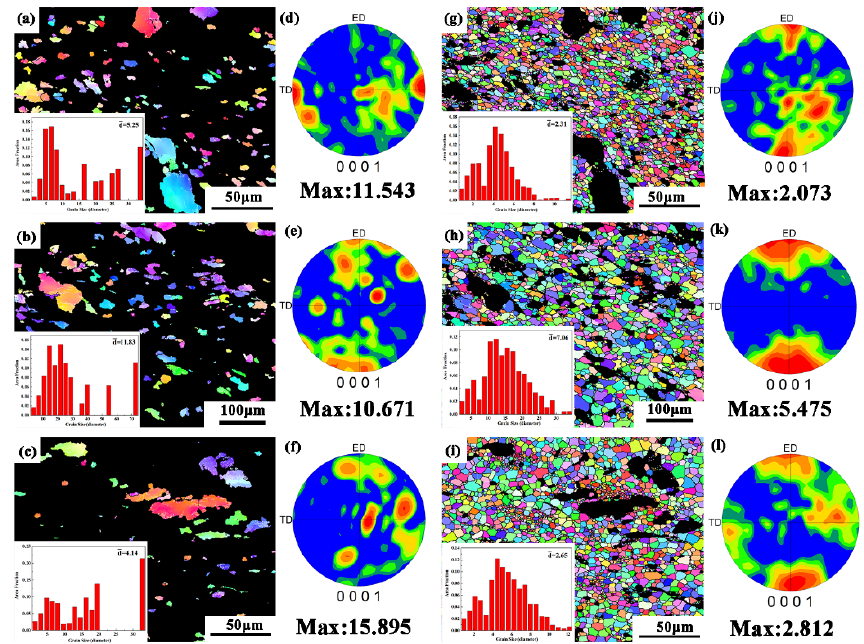
Figure 13. EBSD analysis and Pole figure (PF) analysis of the deformed grains: ( a , d ) L-653 sample; ( b , e ) L-743 sample; ( c , f ) H-743 sample. EBSD analysis and Pole figure (PF) analysis of the DRX grains: ( g , j ) L-653 sample; ( h , k ) L-743 sample ;( i , l ) H-743 sample.